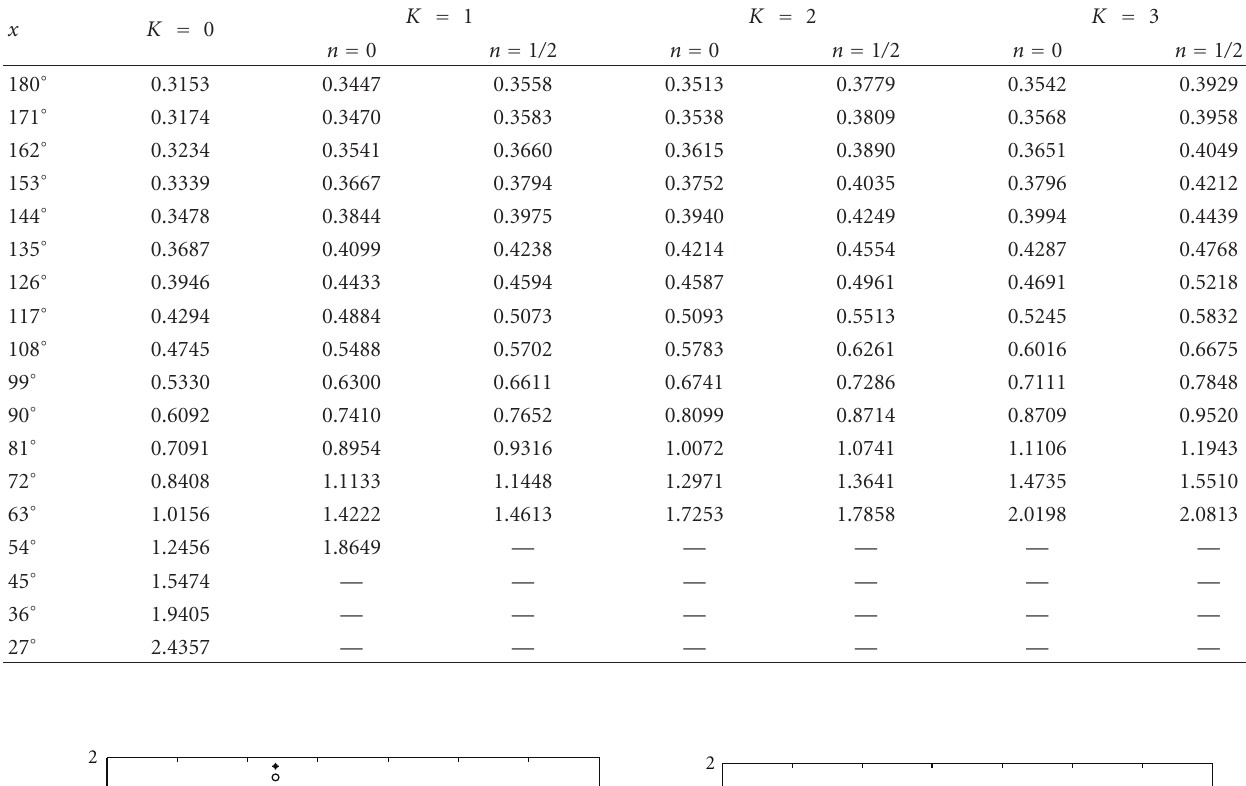
Table 2: The separation times along the cylinder surface when Pr = 7 and α = − 3.